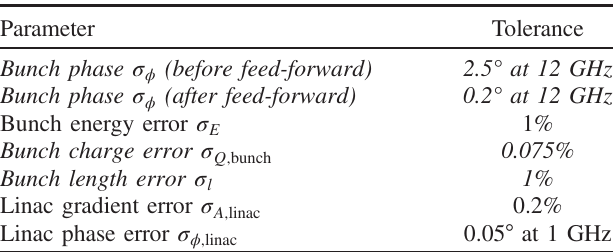
TABLE I. List of CLIC drive beam tolerances for coherent errors causing 1% luminosity loss [4,10]. The primary errors ( italic ) contribute directly to luminosity loss [see Eq. (1)]. Other errors lead to luminosity loss by inducing the primary errors.